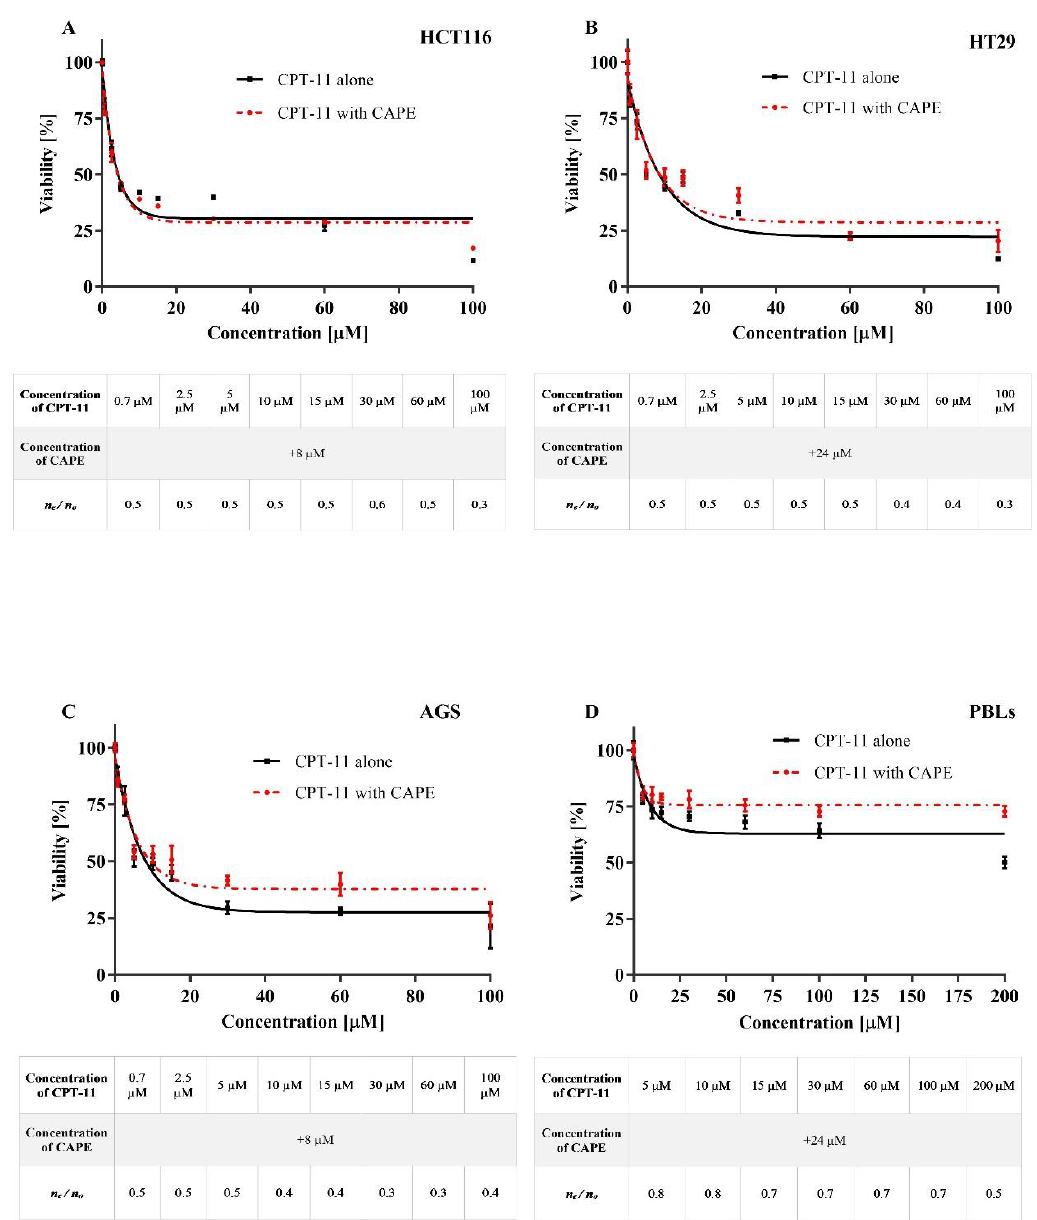
Figure 3. The e ff ect of CPT-11 and co-treatment CAPE + CPT-11 on HCT116 cells ( A ), HT29 cells ( B ), AGS cells ( C ) and PBLs ( D ) growth after 72 h incubation evaluated by MTT assay (the mean ± SEM). Treatment of CAPE and CPT-11 simultaneously shows antagonistic e ff ect on cytotoxicity of HT29, HCT116, AGS cells and PBLs. The figure under the graph show the ratio of expected cell number (n e ) / observed cell number (n o ). For example, treatment of 8 µ M of CAPE or 15 µ M irinotecan decreases cell number of HT29 to 50.00% and 48.00%, respectively, compared to the control (no treatment). The expected cell number of treatment combining 5 µ M of CAPE and 15 µ M irinotecan is 0.50 × 0.48 = 24%. The observed cell number is 48% compared to the control. The ratio is 0.24 / 0.48 = 0.5. Factor < 1 represents antagonistic e ff ect CAPE on